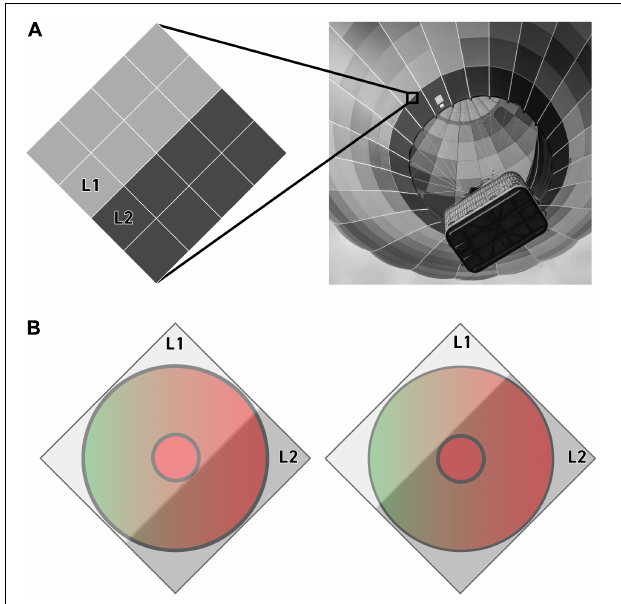
FIGURE 3 | An illustration of the pixels (A) and methodology (B) that our algorithm uses to quantify a receptive field’s response to an achromatic edge. A light gray (L1) and dark gray (L2) pixel are illustrated here moving across the center and surround of a putative L-center vs. L+M surround receptive field. The receptive field’s response to this particular edge is quantified as the difference between the response to each of the two states shown in B (see Eq. 1).